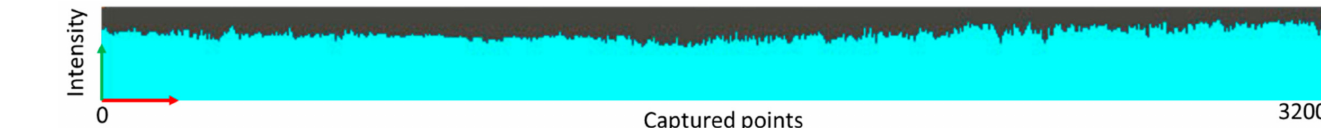
Figure 4. An example of raw intensity data for the full profile (3200 points) provided by the sensor control unit. The X-axis represents captured points, Y-axis represents intensity from 0 to 10 mW.